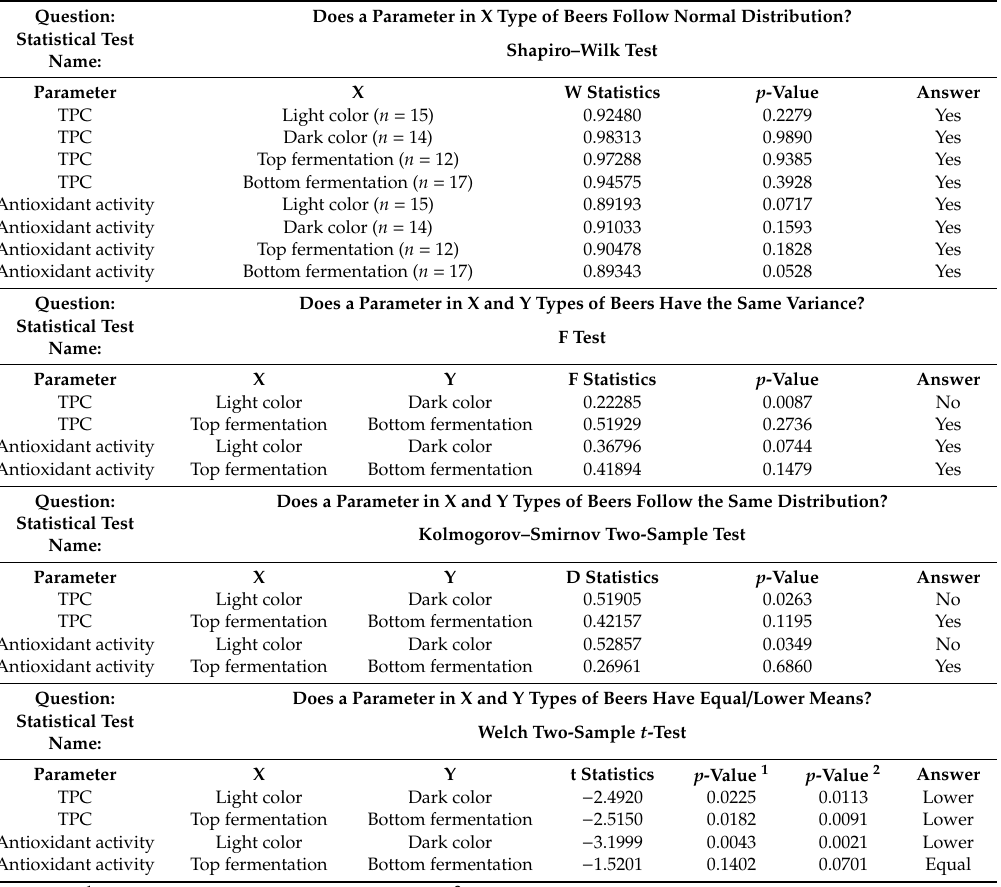
Table 4. Hypothesis testing for the content of total phenolic compounds (TPC) and antioxidant